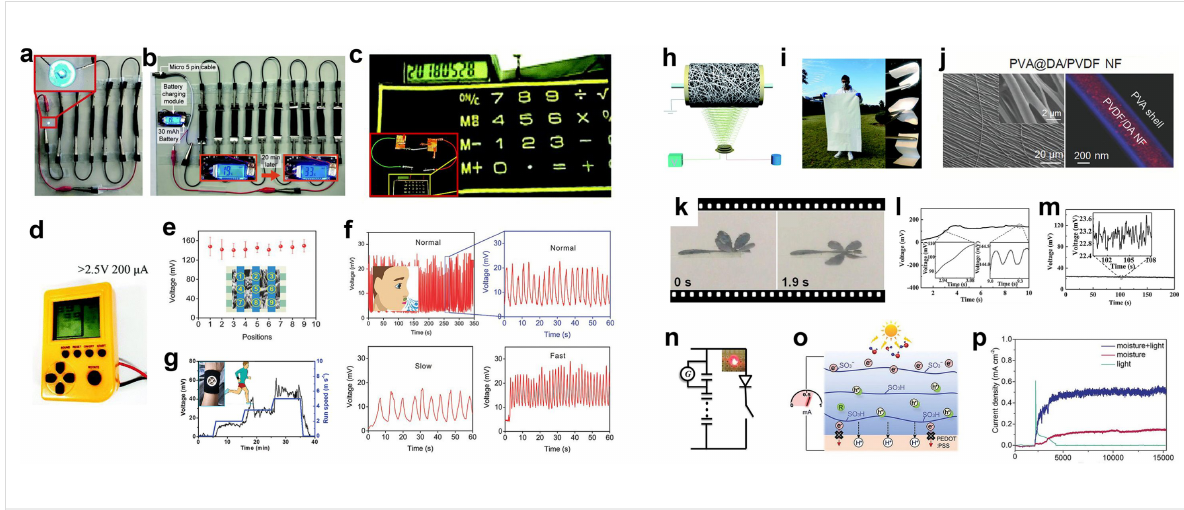
Figure 10: (a) MEGs power directly a blue LED. (b) MEGs charge a battery. Figure 10a,b were reproduced from [55] (“Towards Watt-scale hydroelec- tric energy harvesting by Ti 3 C 2 T x -based transpiration-driven electrokinetic power generators“, © 2022 J. Bae et al., published by Royal Society of Chemistry, distributed under the terms of the Creative Commons Attribution NonCommercial 3.0 Unported License, https://creativecommons.org/ licenses/by-nc/3.0/). This content is not subject to CC BY 4.0. (c) MEG power an eight-digit calculator. (d) MEG light up the LCD screen of a handheld game console. Figure 10c and 10d were republished with permission of The Royal Society of Chemistry from [90] (“An efficient polymer moist-electric generator” by Xu, Tong et al., Energy Environ. Sci., vol. 12, issue 3, © 2019); permission conveyed through Copyright Clearance Center, Inc.